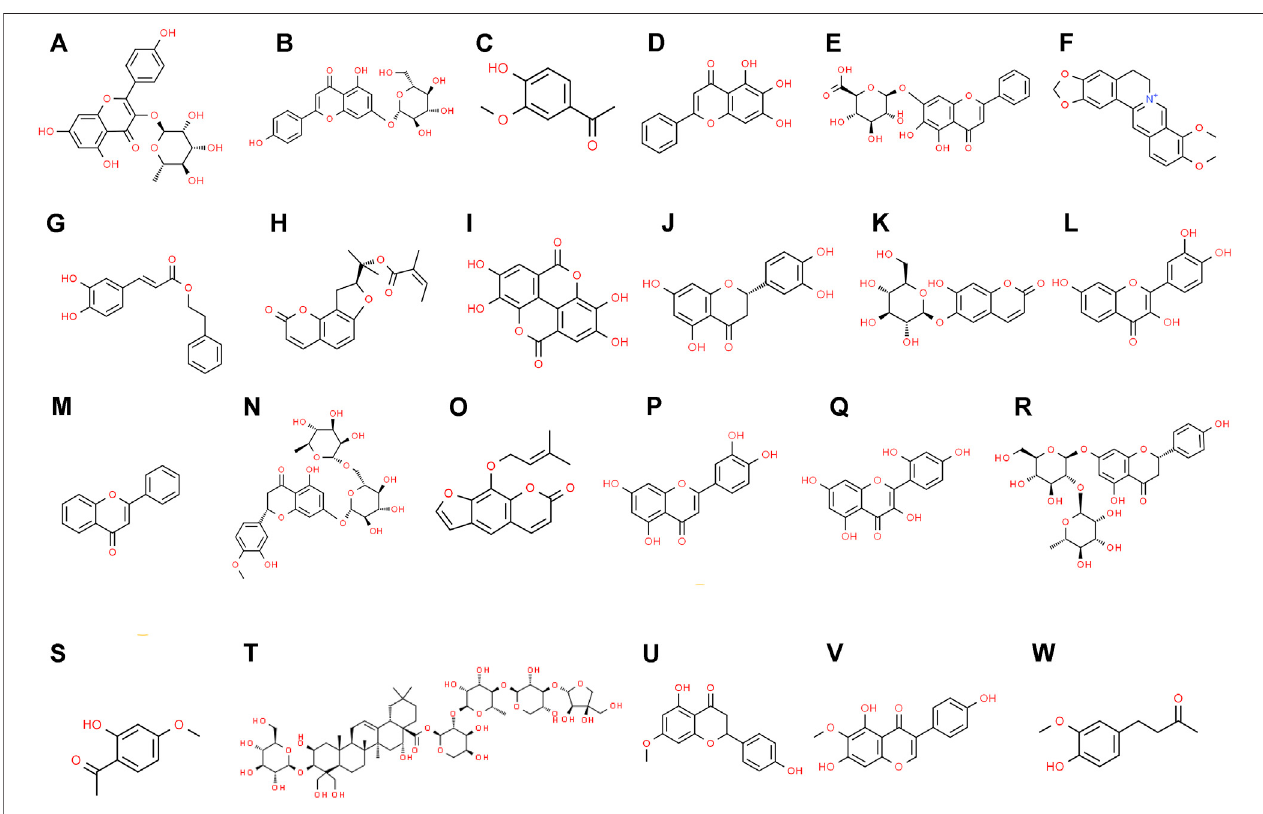
FIGURE 2 | Chemical structures of natural plant products reported against COPD. (A) . Afzelin, (B) . Apigenin-7-glucoside, (C) . Apocynin, (D) . Baicalein, (E) . Baicalin, (F) . Berberine, (G) . Caffeic acid phenethyl ester, (H) . Columbianadin, (I) . Ellagic acid, (J) . Eriodictyol, (K) . Esculin, (L) Fisetin, (M) Flavone, (N) Hesperidin, (O) Imperatorin, (P) Luteolin, (Q) Morin, (R) Naringin, (S) Paeonol, (T) Platycodin D, (U) Sakuranetin, (V) Tectorigenin, (W) Zingerone.